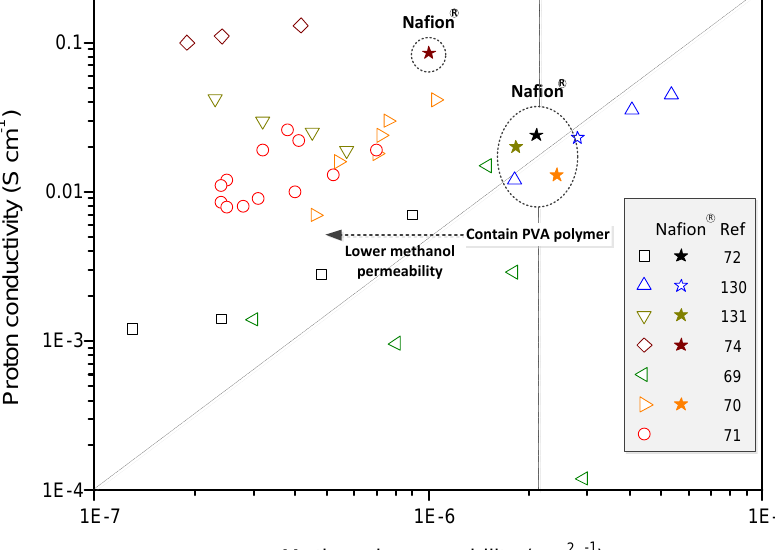
Figure 9. Conductivity versus the methanol permeability of PVA-based crosslinked membranes. Only values given in the text of articles (rather than values that can merely be read from a figure) are plotted. Various Nafion ® values are plotted for